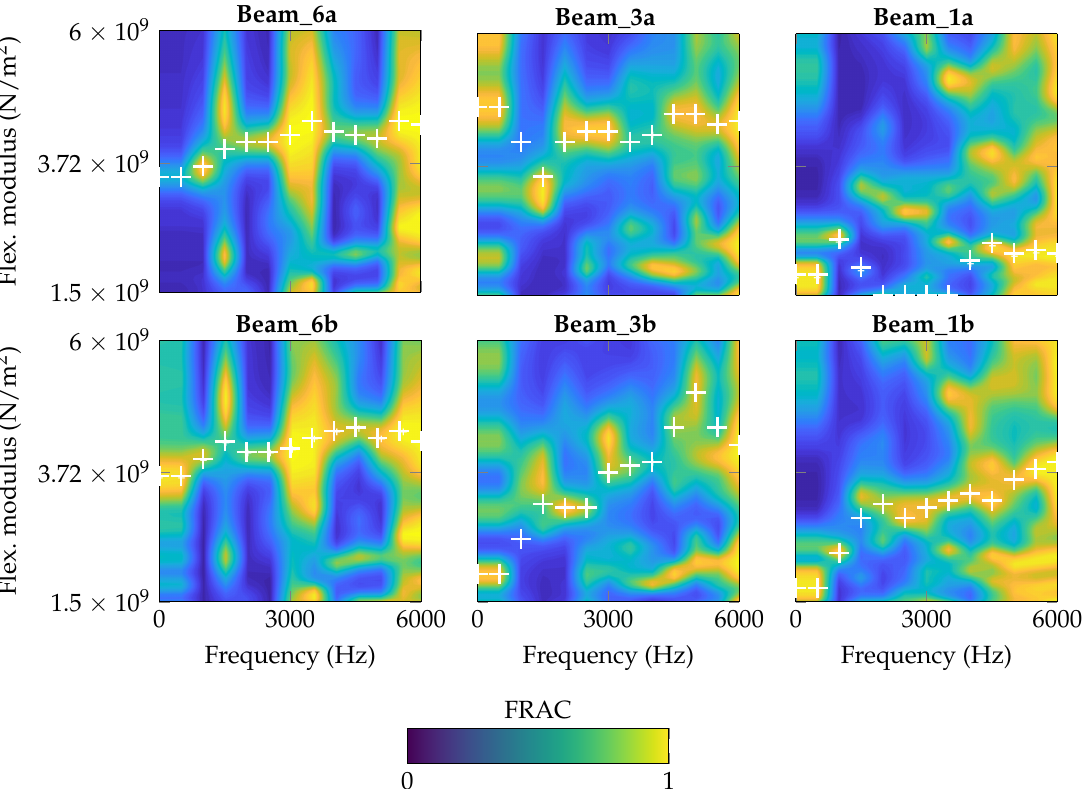
Figure 12. FRAC contour plot for each specimen with identified optima under variation of E (frequency-dependent, constant value for η ).